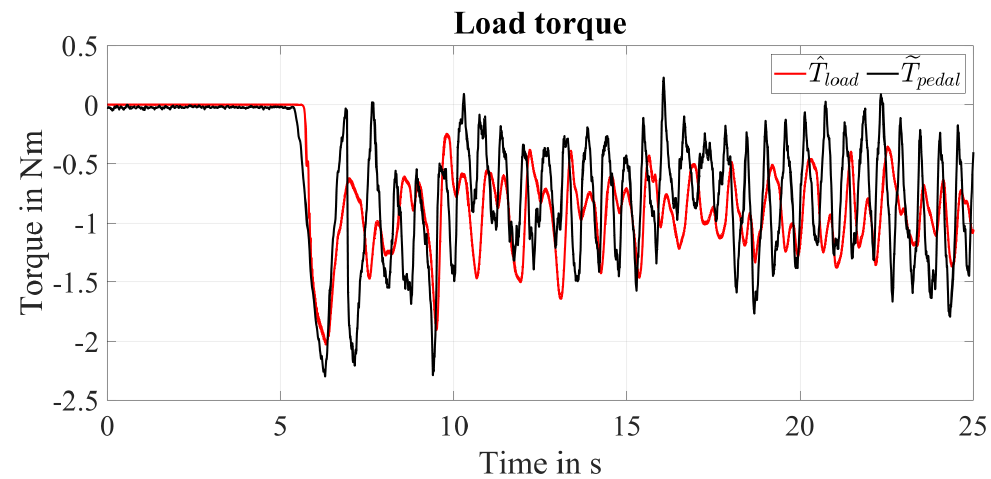
Figure 13. Experiment E3 : Comparison between the estimated load torque and the reconstructed pedalling